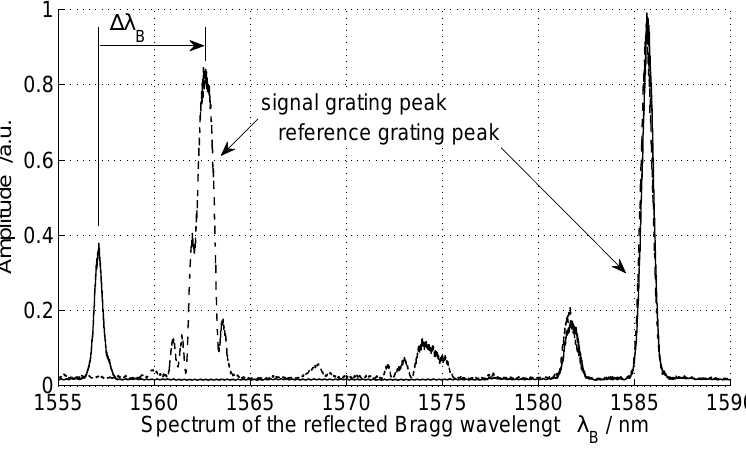
Spectrum of the reflected Bragg wavelength before (—–) and after (- - -)